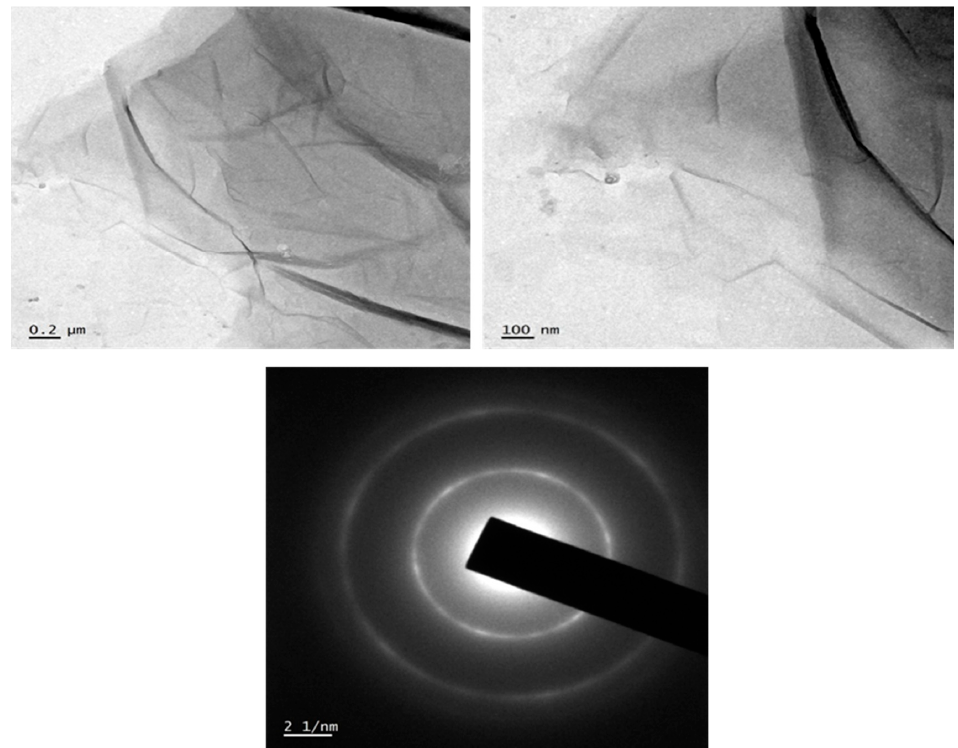
Figure 2. Transmission electron microscopy (TEM) image of synthesized graphene oxide (GO) and Selcted Area Electron Diffraction pattern.